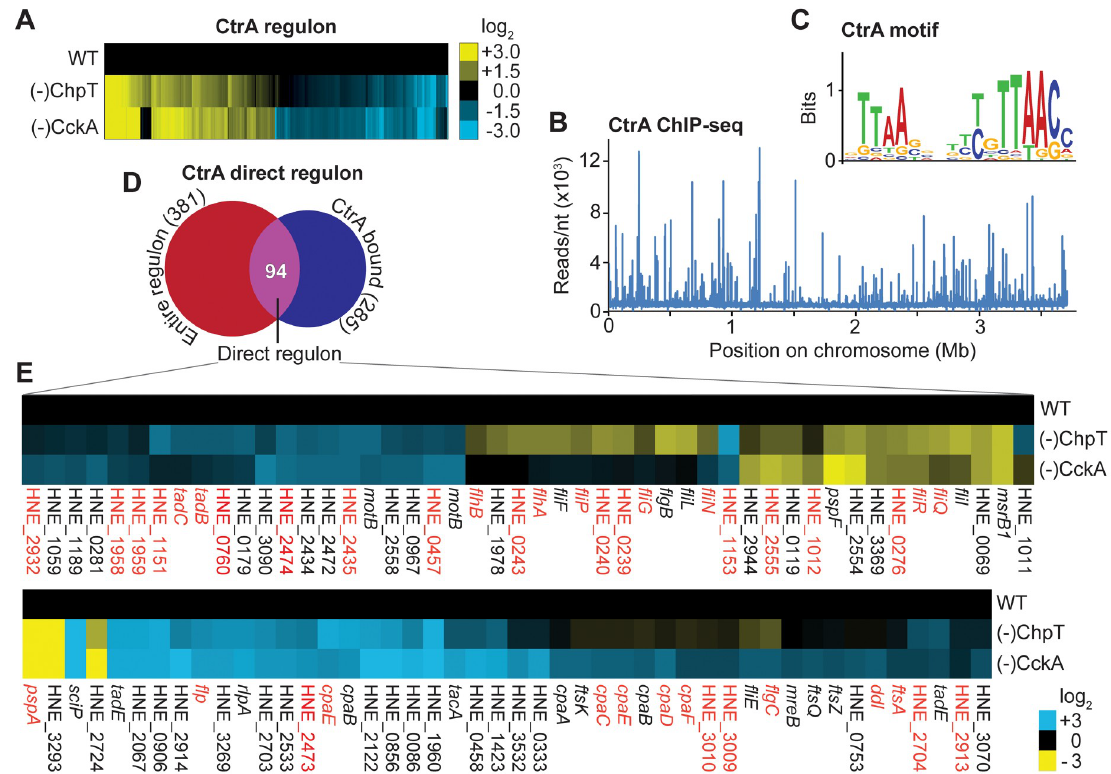
Fig 8. The direct CtrA regulon contains 94 genes. (A) Transcriptional profiles of cells depleted of CckA and ChpT for 24 h. Shown are the log 2 -fold changes in the expression levels of all 381 genes that were differentially regulated upon disruption of the CckA-ChpT-CtrA phosphorelay (as compared to the wild-type strain). (B) Distribution of CtrA binding sites on the H . neptunium chromosome as identified by ChIP-seq analysis. The graph reveals a total of 222 CtrA binding sites, 211 of which are in intergenic regions. (C) CtrA consensus binding motif obtained by a comparison of the 80 chromosomal regions that were most enriched in the ChIP-seq data shown in (B). (D) Venn diagram showing the number of genes (single or in an operon) bound by CtrA (in blue) and the number of genes present in the entire CtrA regulon (in red). The intersection of these two gene sets defines the direct CtrA regulon and comprises 94 genes. (E) Direct CtrA regulon. Shown are the 94 genes contained in the direct CtrA regulon and the log 2 -fold changes in their expression compared to the wild type after depletion (24 h) of ChpT or CckA. Only genes with an RPKM value of > 25, a p-value of < 0.05 and a log 2 -fold difference of > 2 were taken in